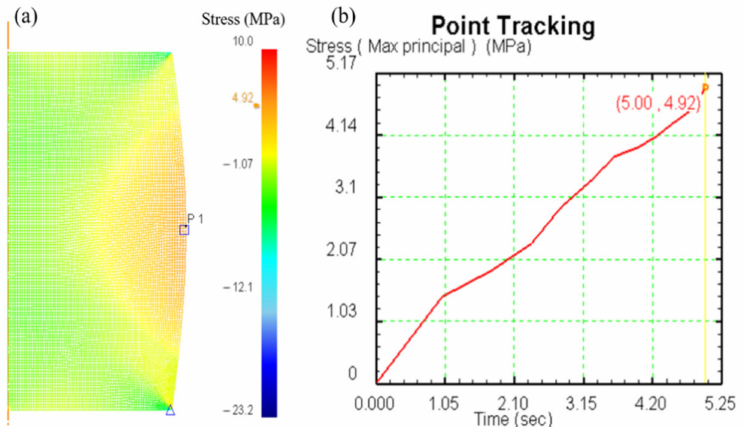
Figure 3. ( a ) Stress distribution of the Bi 0.5 Sb 1.5 Te 3 sample under free state hot compression condition, and ( b ) point tracking of the stress state at the apex of the drum-shaped